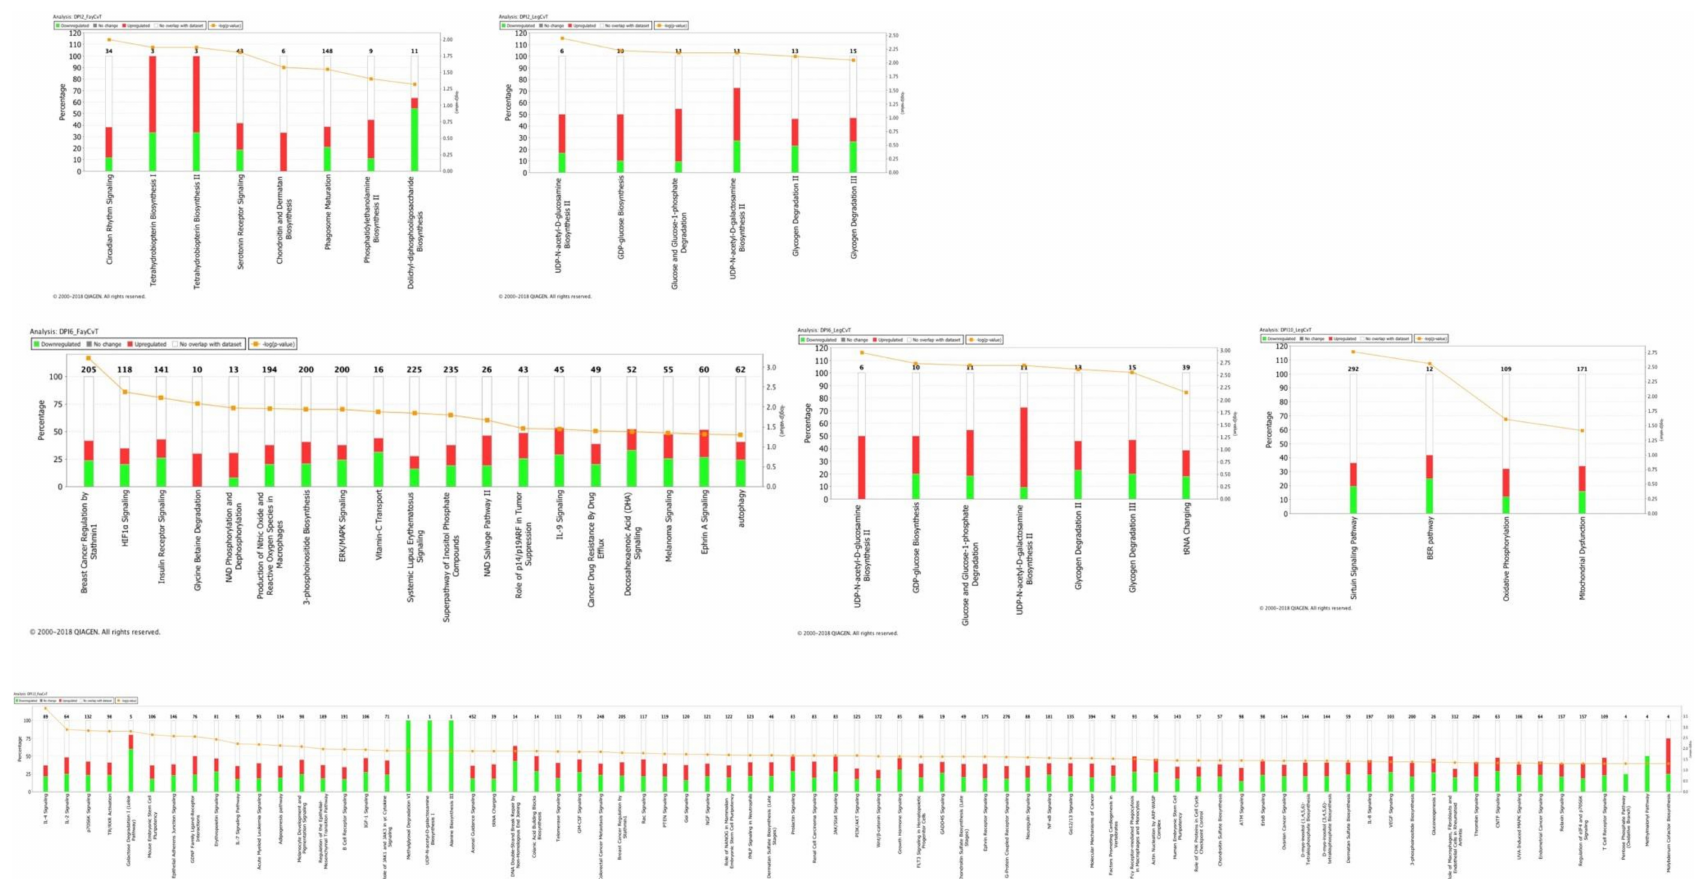
Figure 1. Significantly enriched pathways identified through the Ingenuity Pathway Analysis among the differentially expressed genes by timepoint and genetic line. ( A ) Fayoumi at 2 days post-infection (dpi), ( B ) Leghorn at 2 dpi, ( C ) Fayoumi at 6 dpi, ( D ) Leghorn at 6 dpi, ( E ) Fayoumi at 10 dpi, and ( F ) Leghorn at 10 dpi. The number of genes in each pathway is shown in black, up-regulated (red) and down-regulated genes (green) within the pathway, and the significance value calculated as the − log( p -value) is depicted as an orange